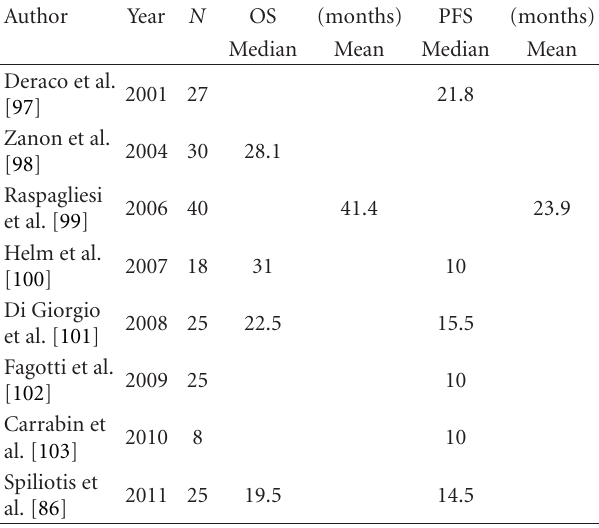
Table 3: Cytoreductive surgery and hyperthermic intraperitoneal chemotherapy in recurrent epithelial ovarian cancer.